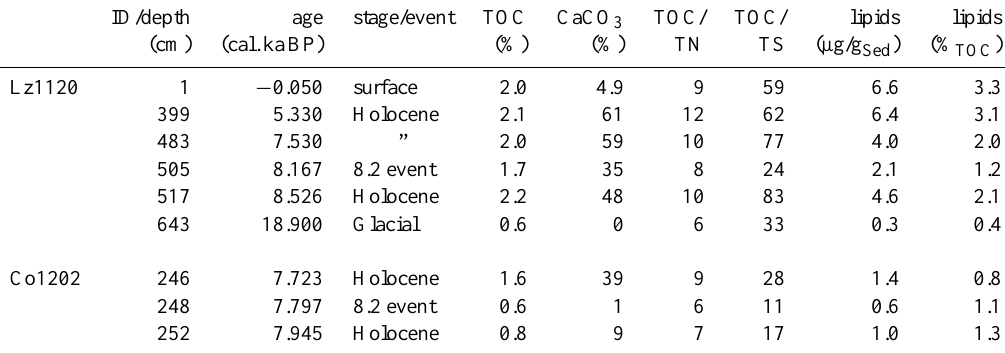
Table 1. Elemental data and concentrations of total lipids per gram sample and as percentage of the total organic carbon content (% TOC ); ages according to Wagner et al. (2008) and Vogel et al. (2010b). Based on the correlation of the carbonate and TOC records we assign sample 248 at Co1202 to the 8.2ka